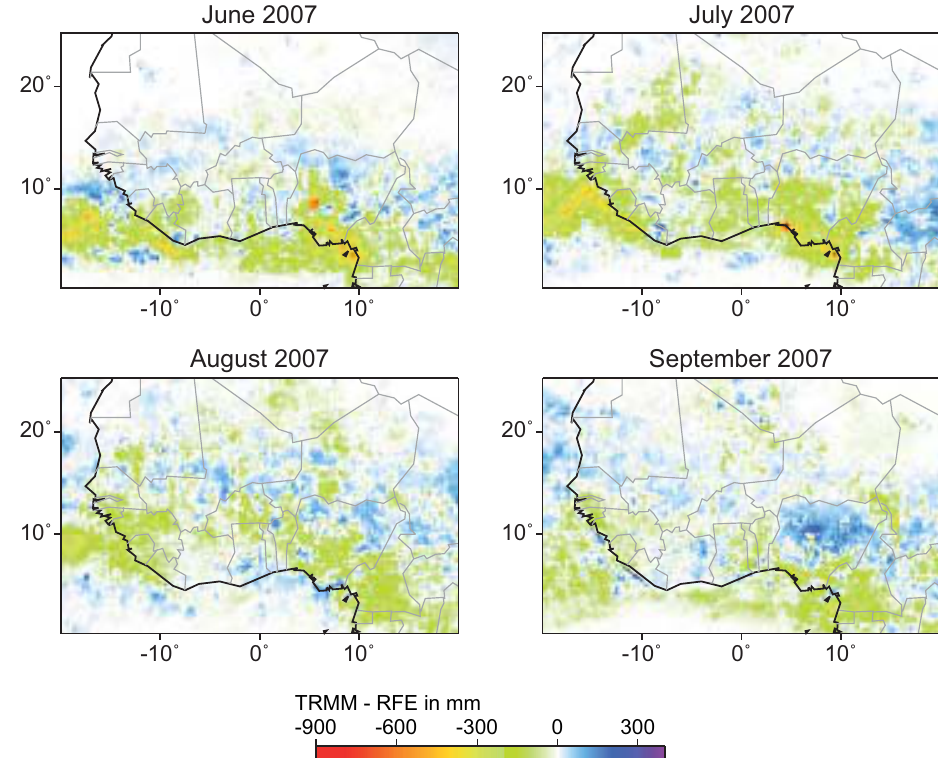
Fig. 1. Differences between TRMM and RFA2.0 rainfall data for the rainy season 2007.